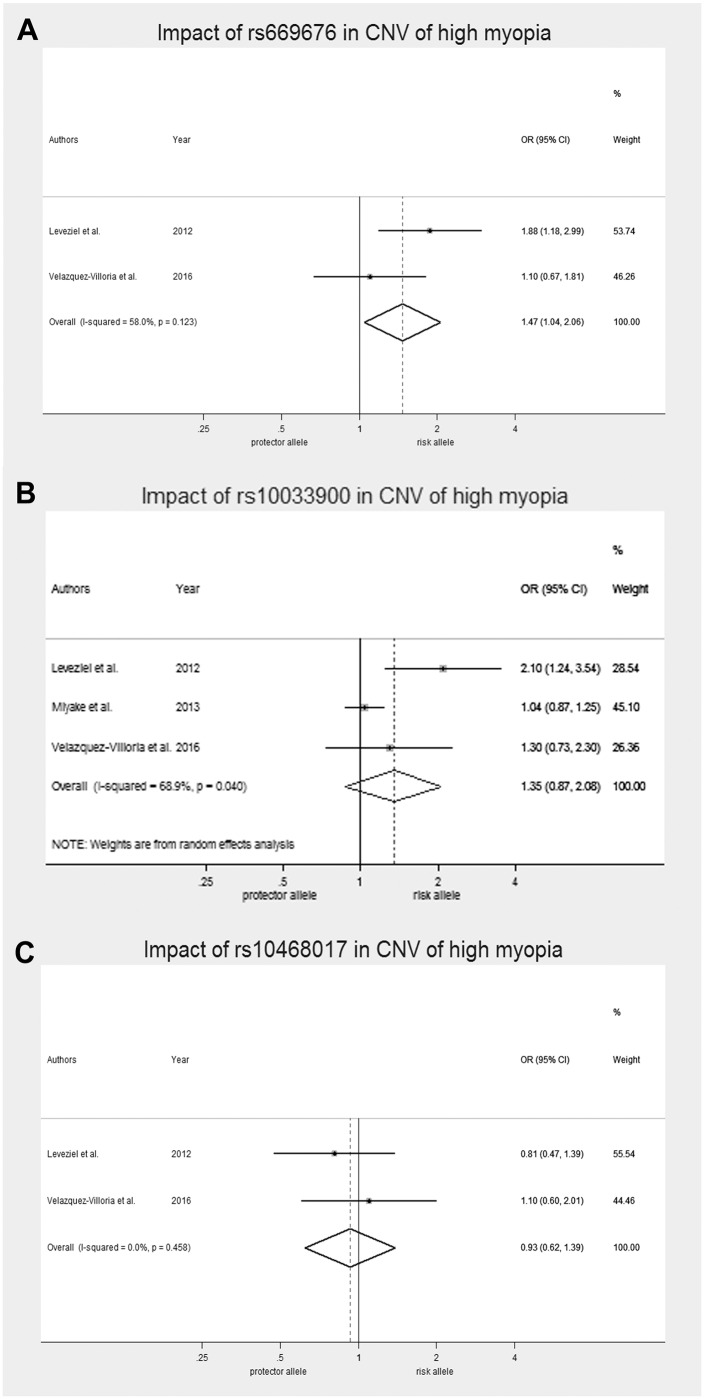
Forest plots of the association of polymorphisms and susceptibility to mCNV.A) Impact of rs669676 in mCNV. B) Impact of rs10033900. C) Impact of rs10468017.